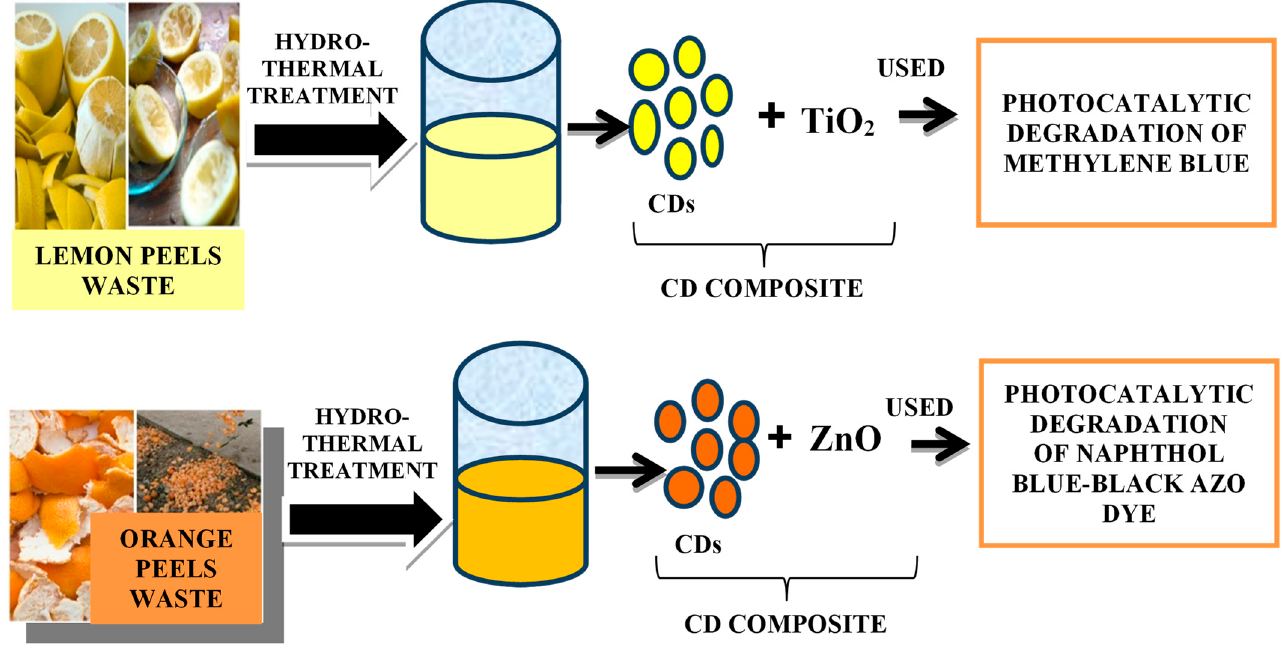
Figure 12. Synthesis of CDs composite from ( top ) lemon peel waste [158] and ( bottom ) orange peel waste [157] and their application for photocatalytic degradation of dyes.